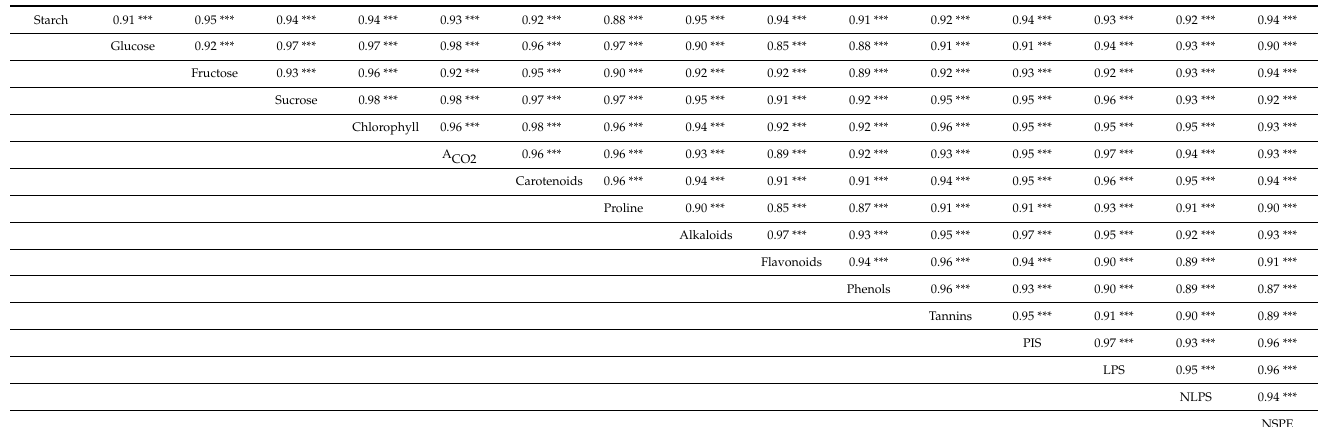
Table 7. Correlation table describing the significance of association between different metabolic, physiological, and growth traits of different cultivars of olives due to different regimes of pre-cooling and BAP